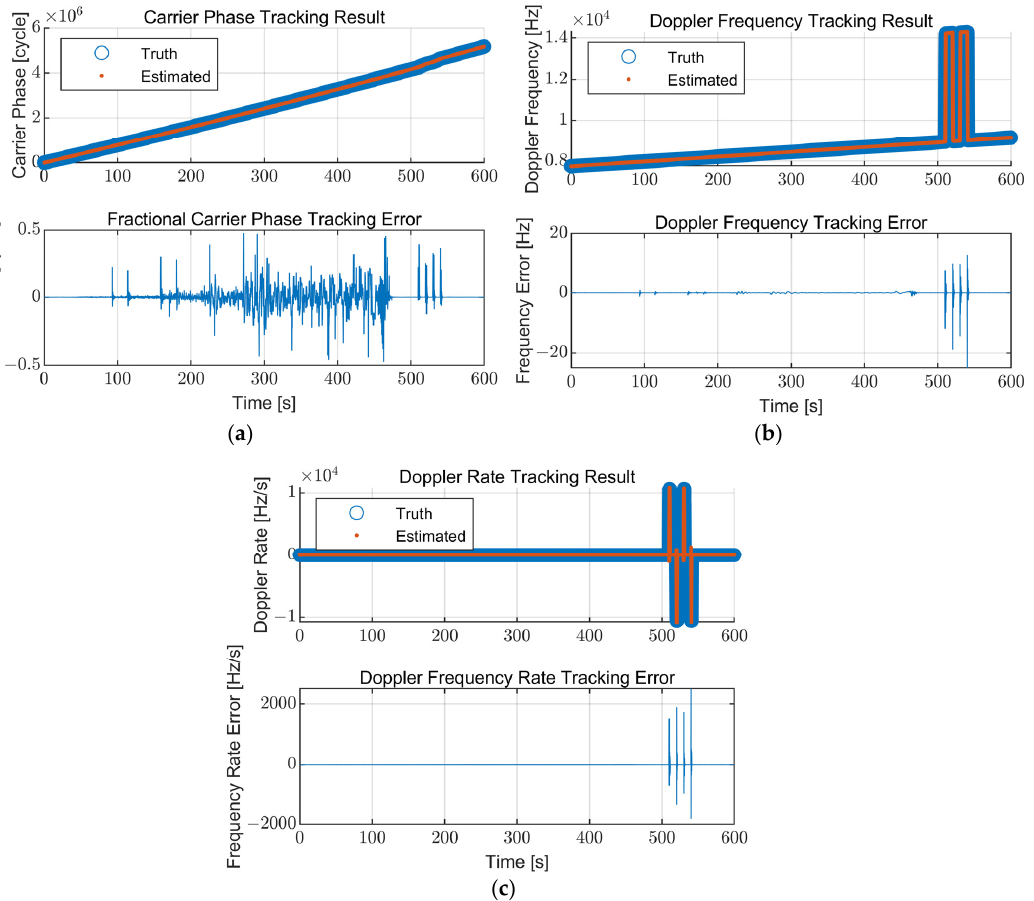
Figure 13. Carrier tracking results of the proposed table-based adaptive DPLL algorithm: ( a ) Carrier phase; ( b ) Doppler frequency; ( c ) Doppler rate. The proposed algorithm stably tracks the signal components for the simulation scenario.